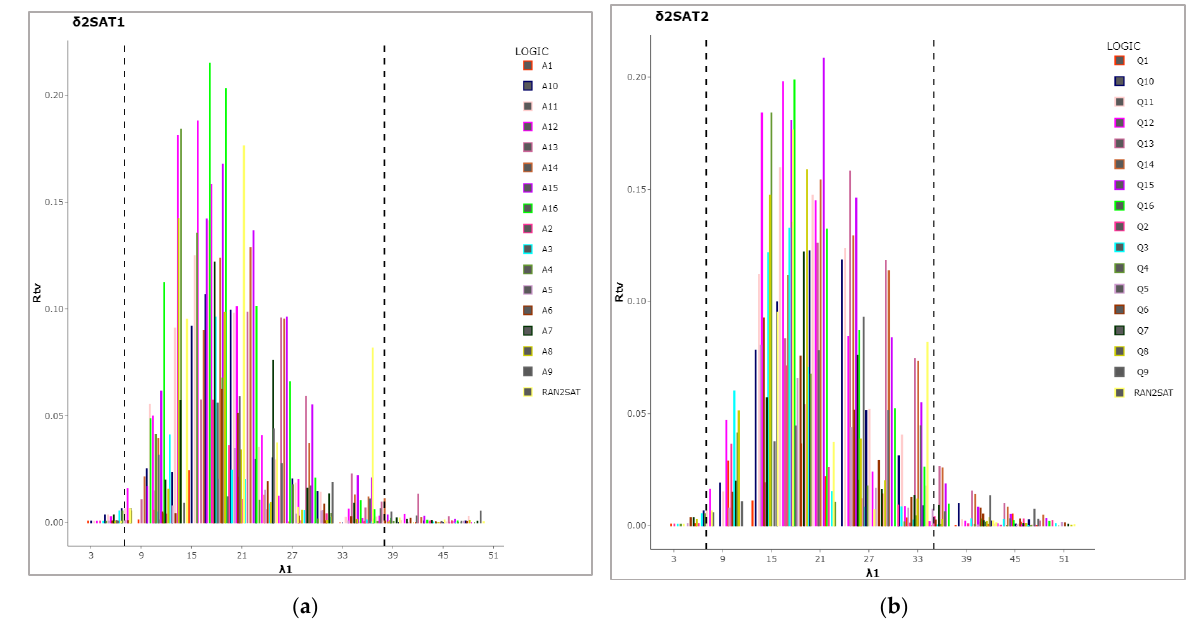
Figure 13. column representation for models in both types of logic (a) 1 2 SAT   Figure 13. Column representation for models in both types of logic ( a ) δ 1 2 SAT ρ , ( b ) δ 2 2 SAT ρ and and RAN2SAT.